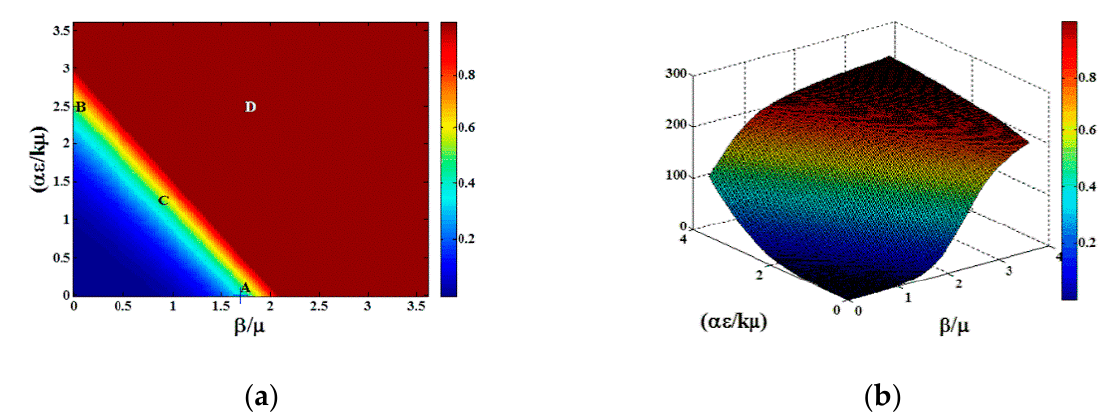
β (cid:15)α µ , and R indirect = µ k with the